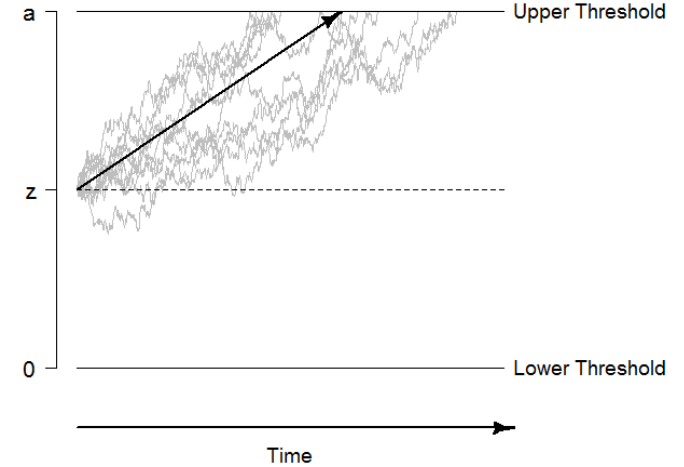
Figure 1. Graphical illustration of the drift-diffusion model. The decision process starts at the starting point z , and information is accumulated until the boundary a is reached. The systematic part of the accumulation process, the drift rate v , is illustrated with the black arrow. The non-decision time t 0 is not included in this